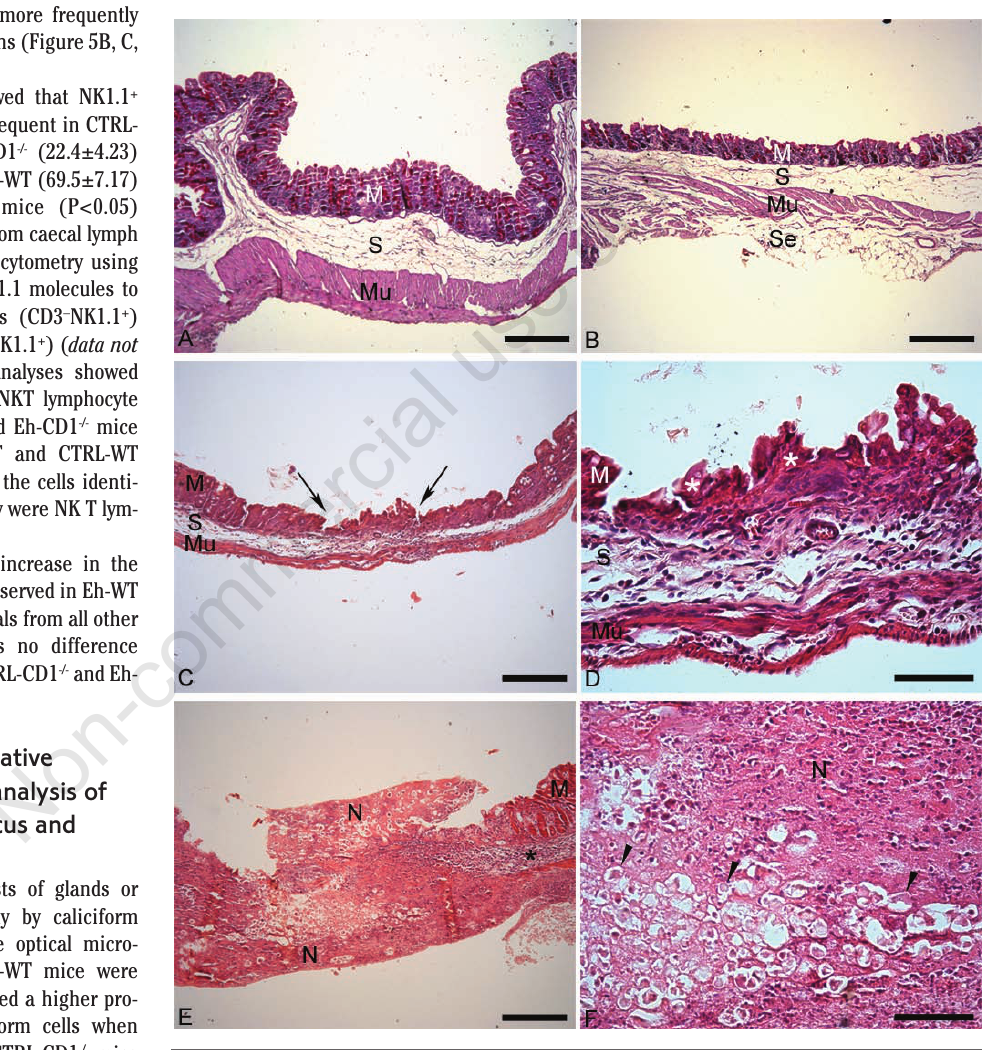
Figure 2. Photomicrograph of caeca of C57BL/6 wild type and C57BL/6CD1 -/- mice inoculated or not with Entamoeba histolytica . A) non-infected-wild type group: mucos- al, submucosal and muscular layers with normal aspect. Periodic Acid Schiff (PAS) stain. Bar = 100 µm; B) non-infected-CD1 -/- group: caecum showing a thin mucosal layer. PAS. Bar = 100 µm; C) Entamoeba-wild type group: caecum with erosion (arrows) in the mucosa. Haematoxylin and Eosin (H&E). Bar = 100 µm; D) higher magnification of the previous figure showing partial destruction (*) of the mucosa and discrete inflammatory infiltrate in the submucosa. H&E. Bar = 30 µm; E) Entamoeba-CD1 -/- group: extensive necrosis (N) in all layers of the caecal wall. Inflammatory infiltrate in the submucosa (*). H&E. Bar = 100 µm; F) higher magnification of the previous figure showing necrosis (N) and high number of trophozoites (arrowheads). H&E. Bar = 30 µm. Mucosa (M), Submucosa (S), Muscular (Mu) and Serosa